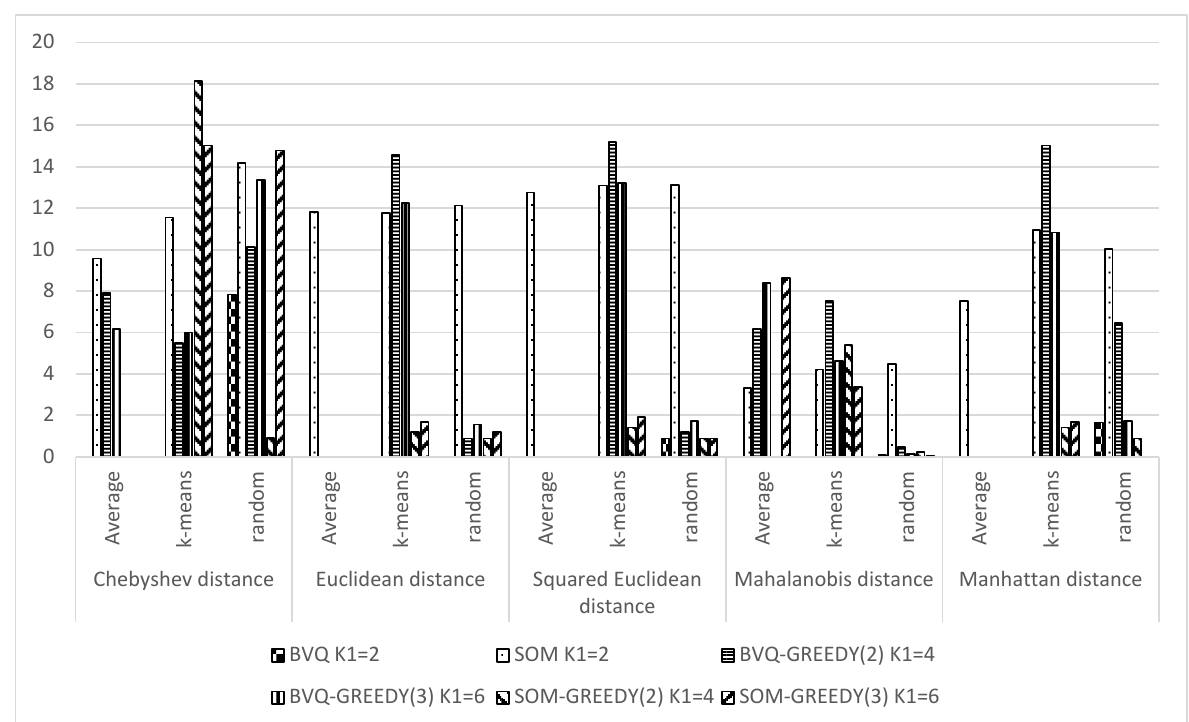
Figure 4. Coefficient of variation of the objective function value for the three ‐ batch mixed lot.